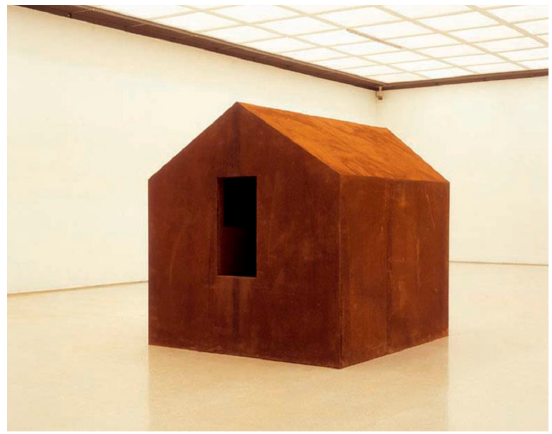
Figure 7. Micha Ullman, Midnight , from the series “Containers,” 1988. Iron and red sand, 320 cm × 240 cm, height: 253 cm. Photograph: Israel museum, Jerusalem/Avraham Hay.